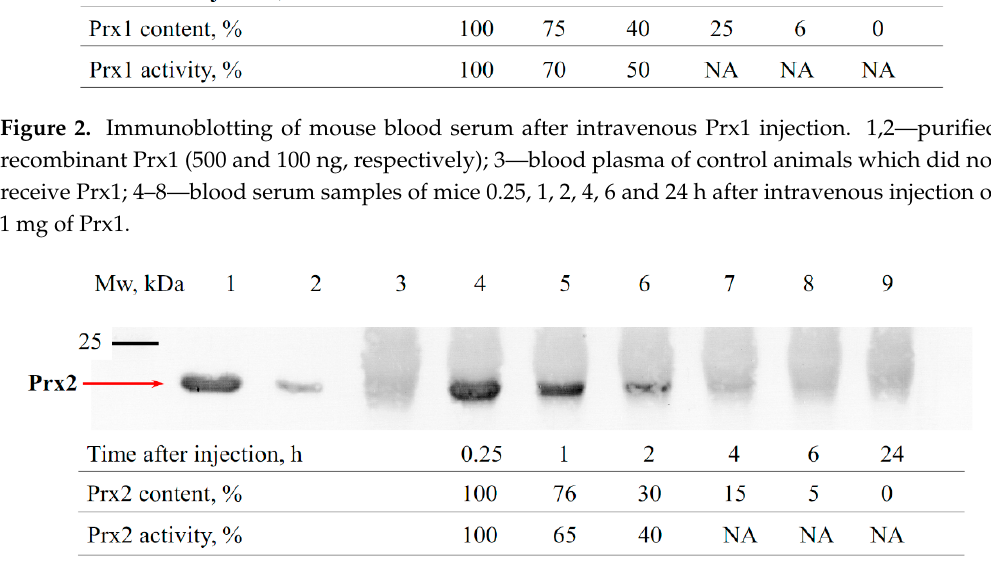
Figure 3. Immunoblotting of mouse blood serum after intravenous Prx2 injection. 1,2—purified recombinant Prx2 (500 and 100 ng, respectively); 3—blood plasma of control animals which did not receive Prx2; 4–8—blood serum samples of mice 0.25, 1, 2, 4, 6 and 24 h after intravenous injection of 1 mg of Prx2.